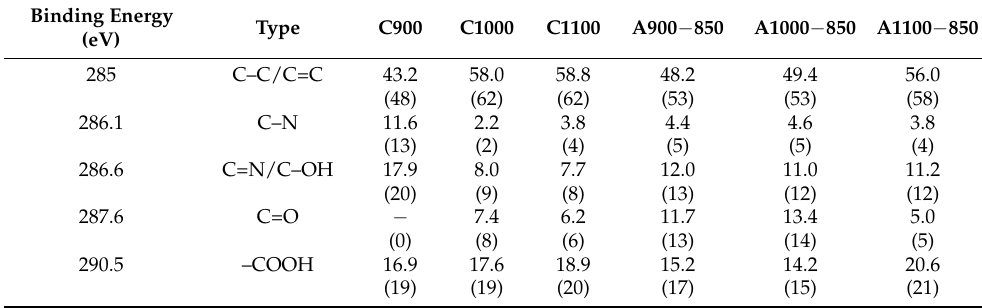
Table 3. Results of the fits of the XPS N 1s region, values given in at.% (percent of total intensity). Binding Energy